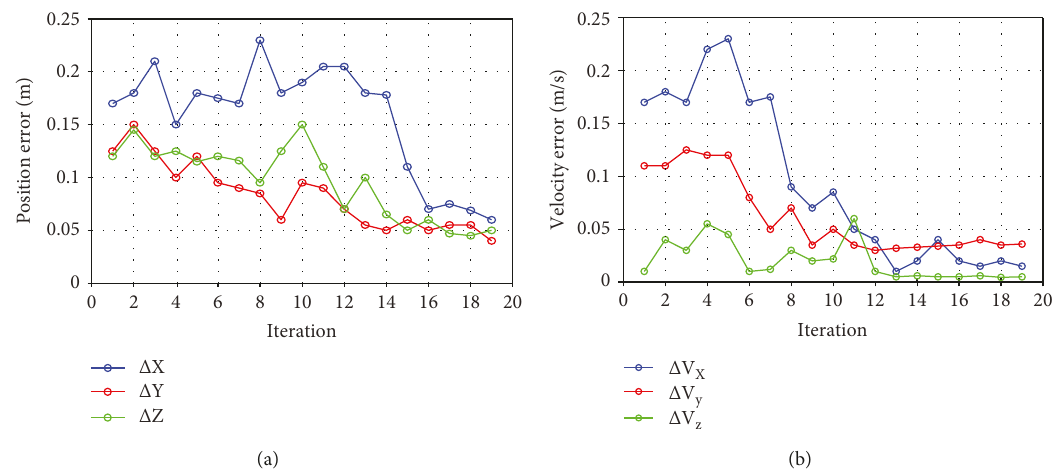
Figure 5: The di ff erence between the estimated initial (a) center of mass position and (b) velocity vectors.